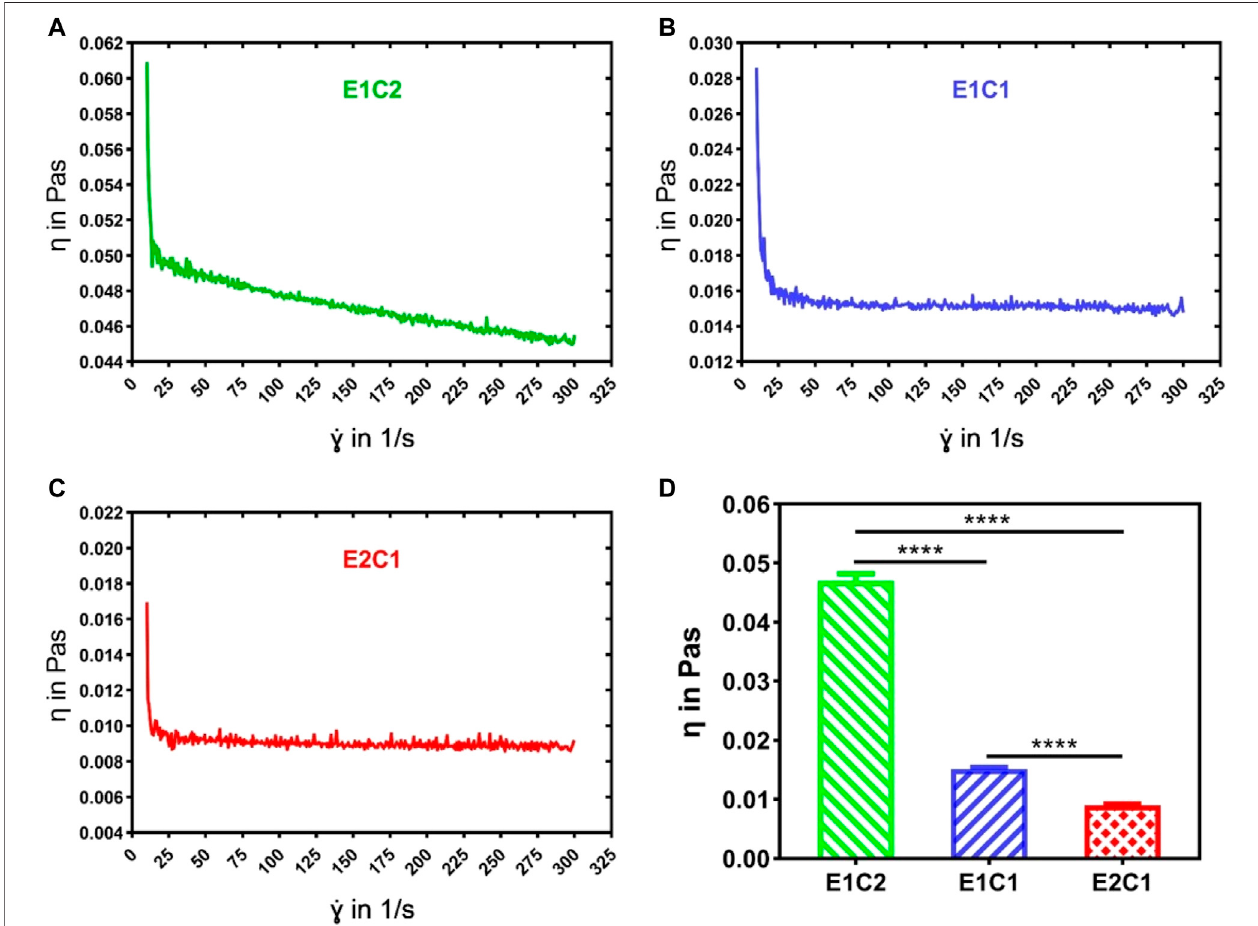
FIGURE2| Theviscosity curves of thethree mixed solutions weredetectedby therheometer: (A) E1C2, (B) E1C1, (C) E2C1, (D) Statistical results ofthe viscosity of the three mixed solutions. **** p < 0.0001.